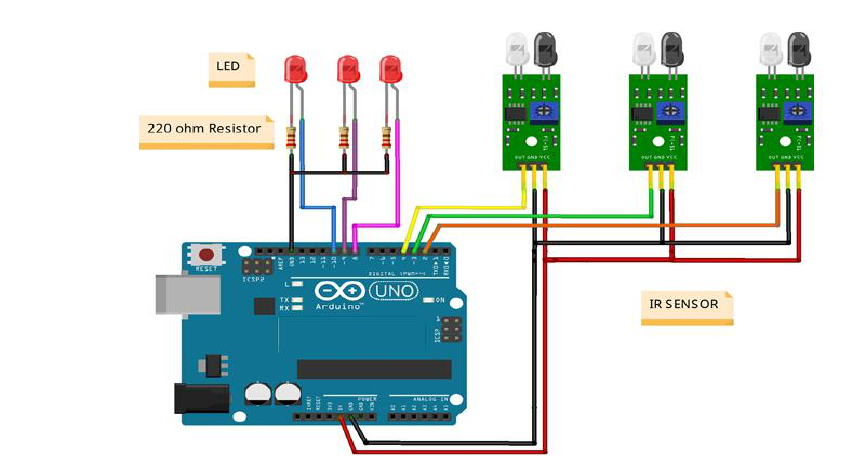
Figure 1 –Design of a street lighting system Рис. 1 – Проект уличного освещения Слика 1 – Пројекат система уличног